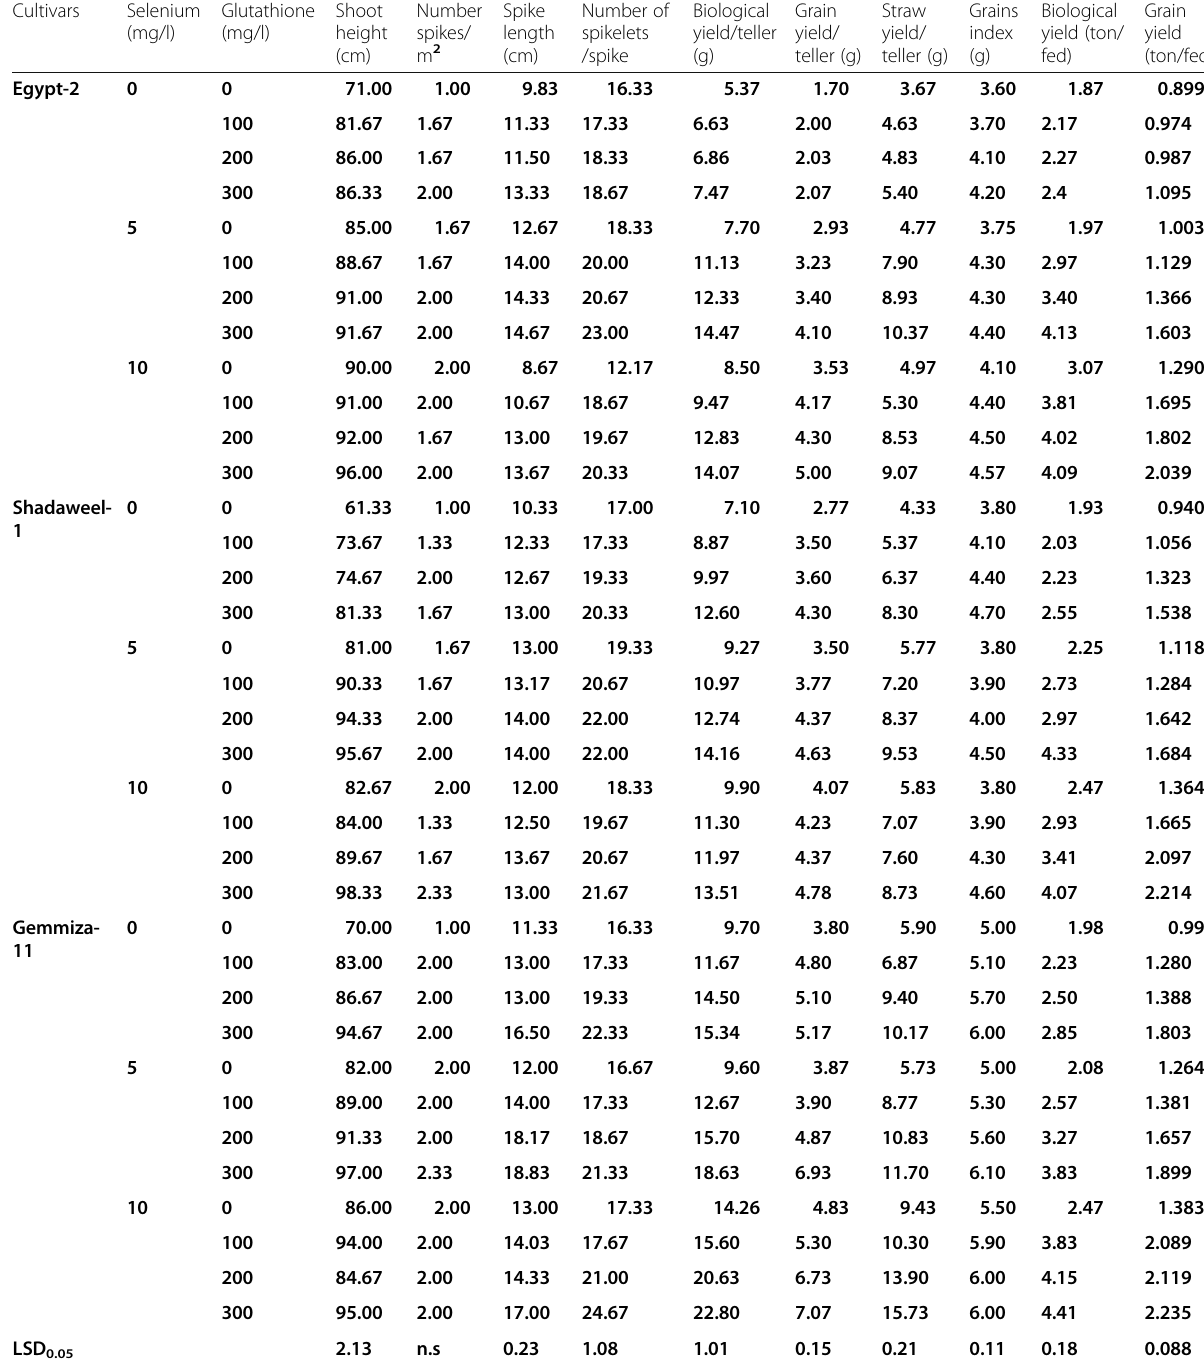
Table 3 Effect of glutathione and/or selenium on grain yield and yield components of three wheat cultivars grown under conditions of the Nubaria region